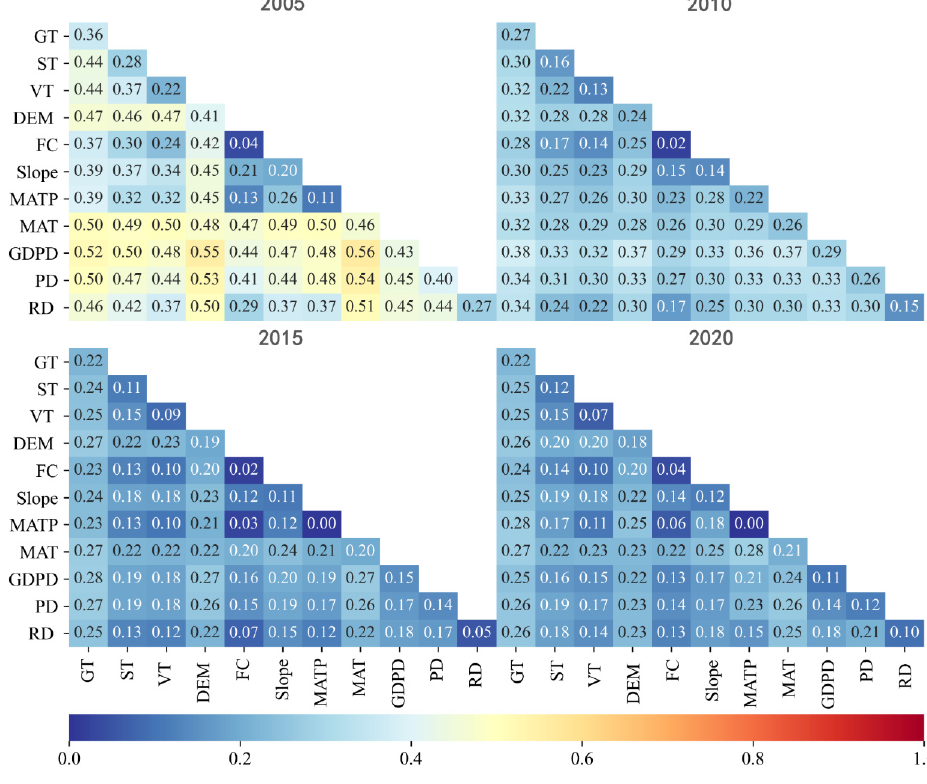
Figure 9. Interaction of factors affecting cropland abandonment.